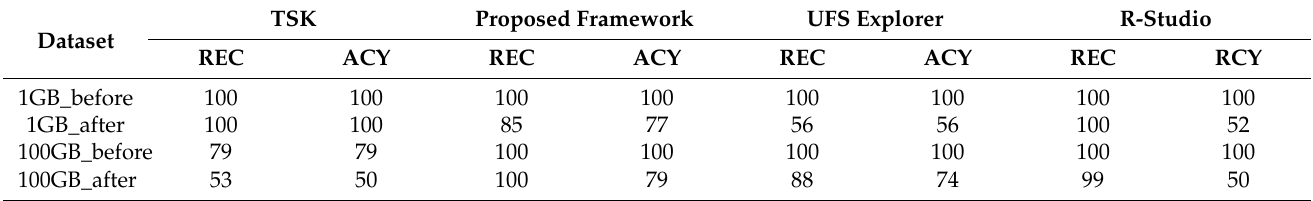
Table 4. Experimental result based on recovery rate and accuracy for Ext4.